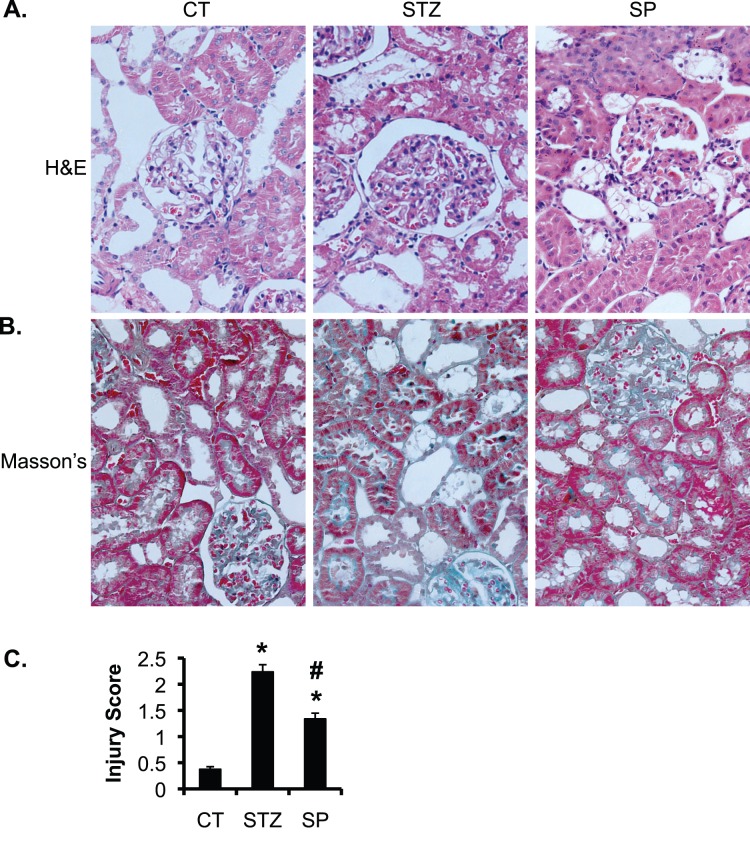
Spironolactone significantly improves glomerulosclerosis and tubulointerstitial injury in STZ-induced diabetic rats.(A–B) As in Fig. 1, representative renal histological images showing hematoxylin and eosin stain (A) and Masson’s Trichrome stain (B) of the rats in the three groups as indicated. (C) Whole kidney average score of tubulointerstitial injury based on Masson’s Trichrome stain. n = 8 rats/group. *P<0.05 vs. CT. #P<0.05 vs. STZ.